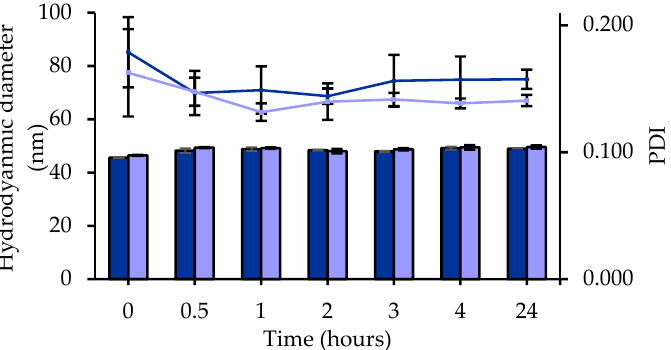
Figure 5. Stability profile of Tg-NEs estimated by the hydrodynamic diameter (bars) and the polydispersity index (line) in PBS pH 7.4 after 1/100 (dark blue) and 1/500 (light blue) dilutions ( n = 3, data are shown as the mean ± SD).